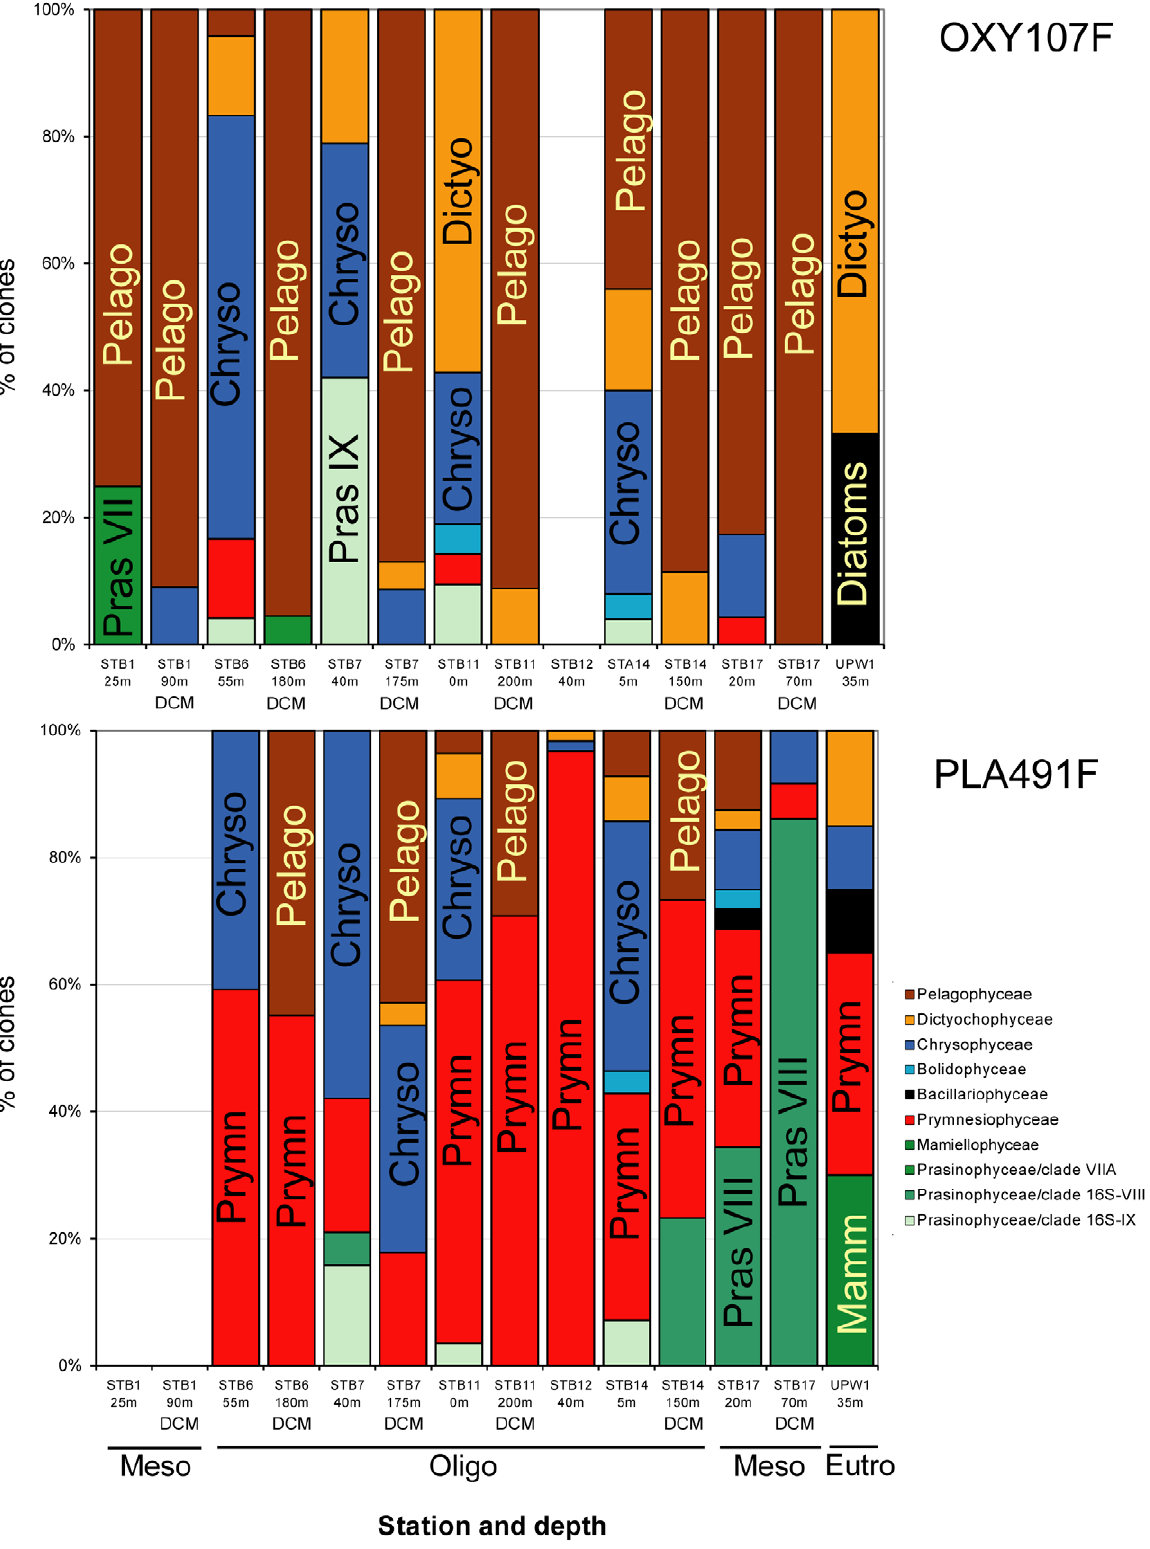
Figure 6. Detailed composition of plastid 16S rRNA gene clone libraries constructed with two primer sets. Primer sets: OXY107F/ OXY1313R and PLA491F/OXY1313R. Composition is expressed as percent of clones. Oligo, Meso and Eutro correspond to the three major regions considered: oligotrophic, mesotrophic, and eutrophic.